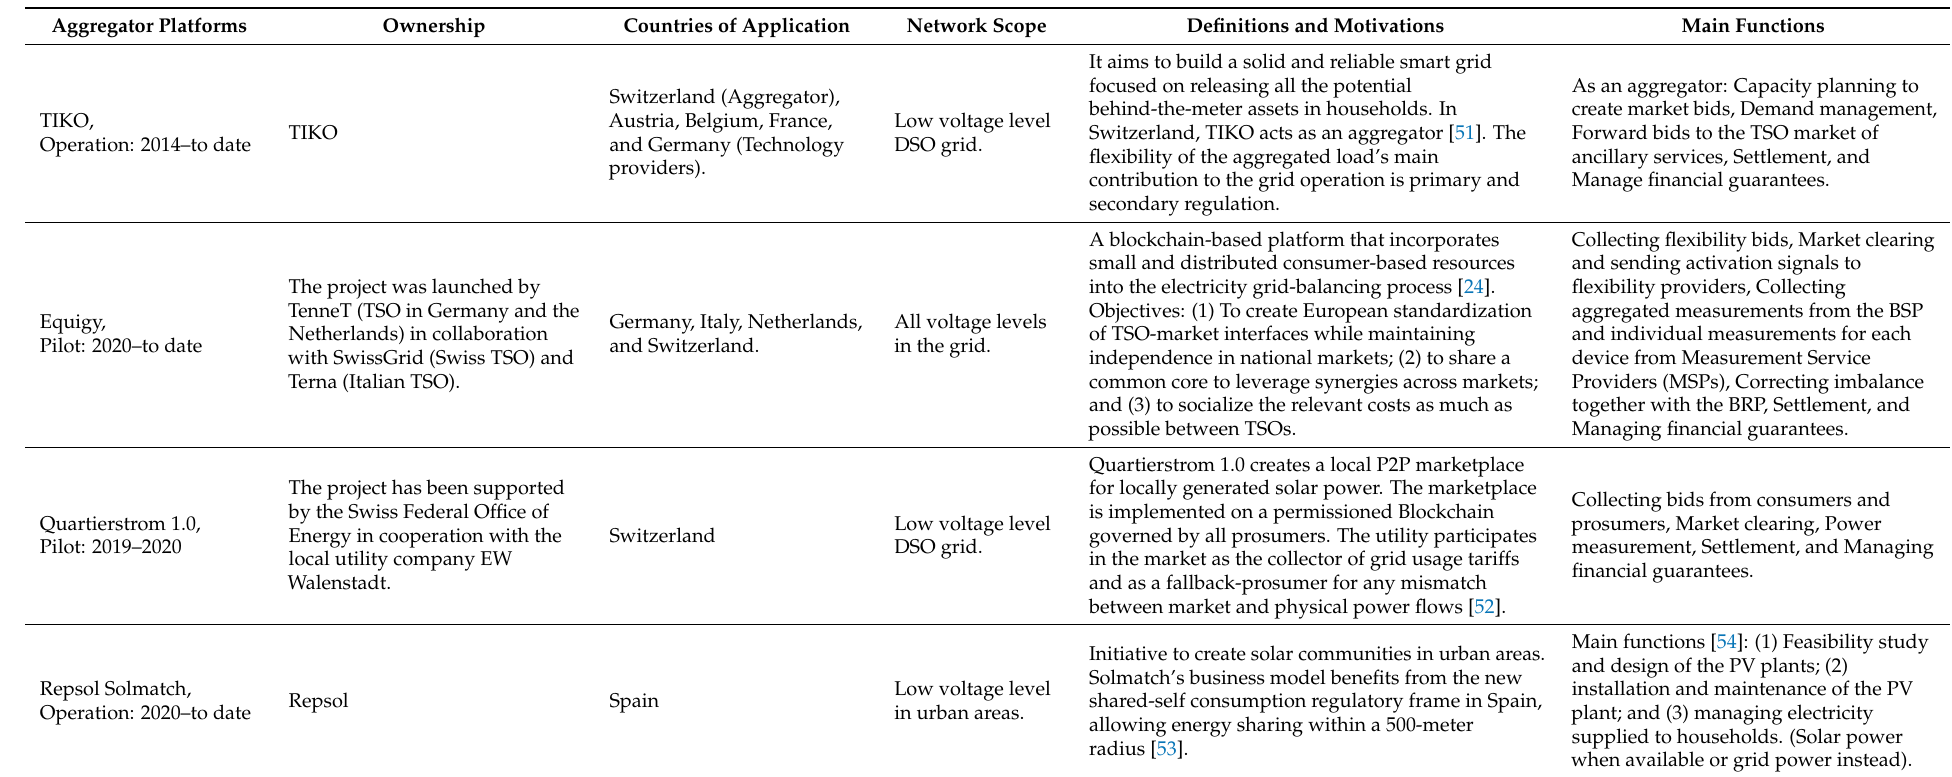
Table 5. Description of the aggregator